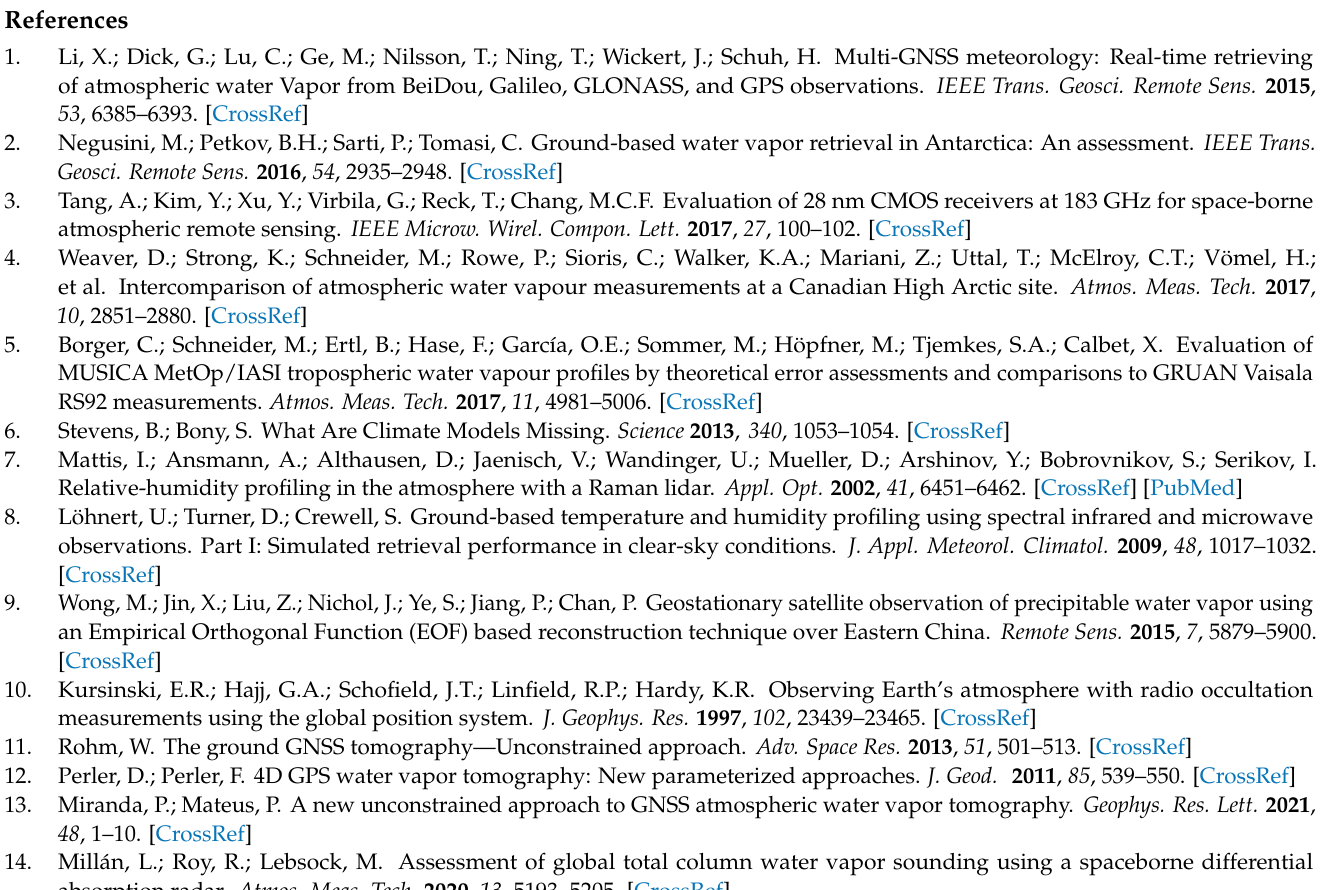
Figure A4. Differences in the wind field (direction and intensity) between the ASSIM runs (where Prof: WV vertical profile and Int: integrated PW) and VR and between CTRL and VR, for the case study of 24 September 2020 at 18UTC (subplots a , d , g ), 21UTC (subplots b , e , h ), and 00UTC of 25 September (subplots c , f , i ), respectively. The results are for the Valley